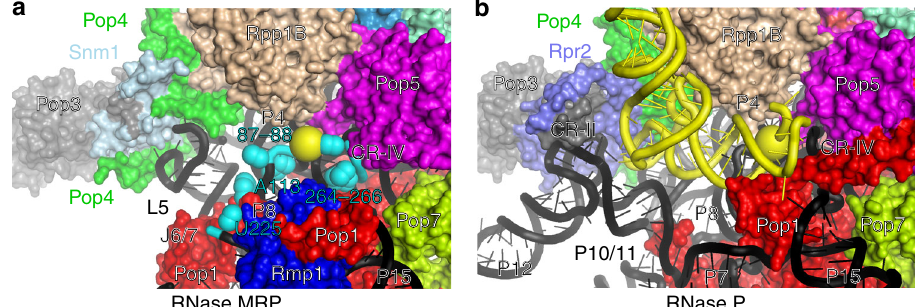
Fig. 6 Substrate binding pockets in RNase MRP and RNase P. Protein components are color coded according to Fig. 2. RNase MRP and RNase P RNAs are shown as cartoons in black. The substrate pre-tRNA in the substrate binding pocket of RNase P 21 ( b ) is shown as a cartoon in yellow. The location of the scissile bonds is shown by yellow spheres ( a , b ). The locations of the RNase MRP nucleotides that crosslink to substrates 20 are shown as spheres in cyan (